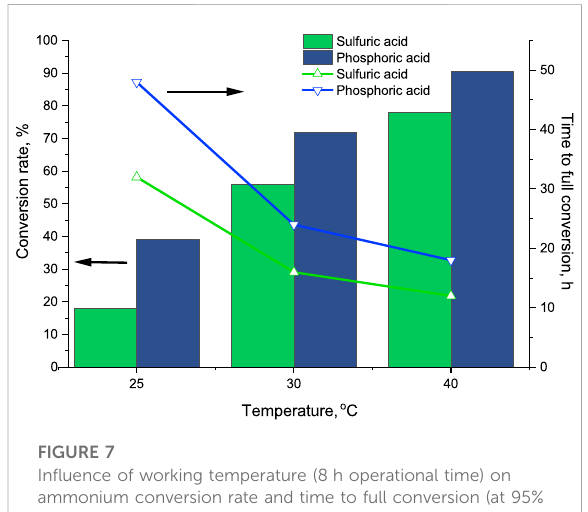
FIGURE 7 In fl uence of working temperature (8 h operational time) on ammonium conversion rate and time to full conversion (at 95% conversion rate). Shellside line: the regeneration solution, 5M NaCl, pH 12; lumenside line: 5% sulfuric or phosphoric